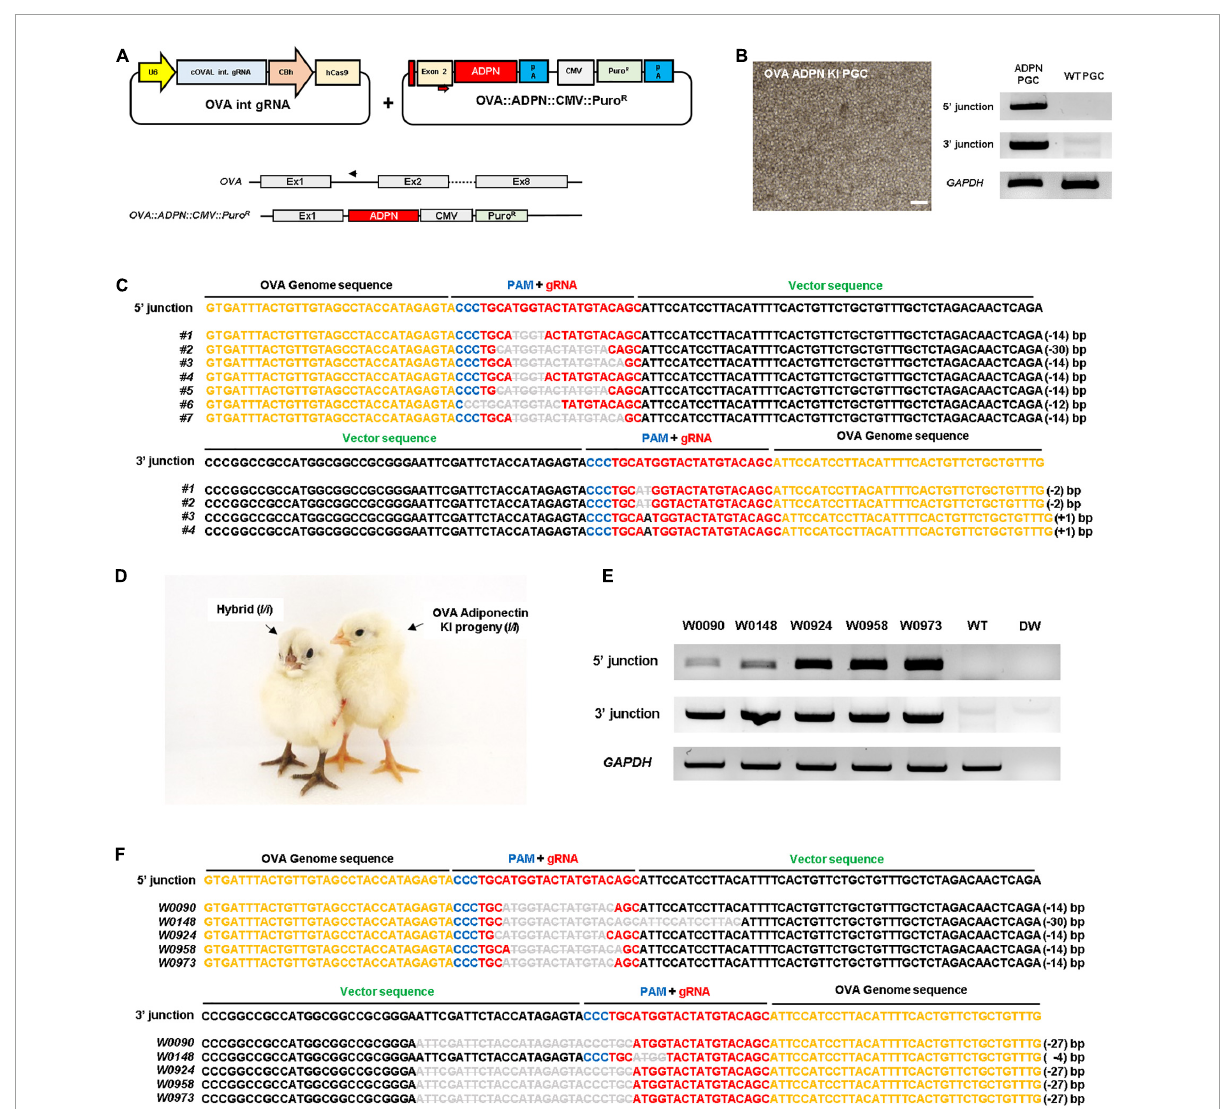
FIGURE1 Targeted gene insertion of human ADPN at Ovalbumin (OVA) gene locus of chicken PGCs and establishment of transgenic chickens. (A) A schematic illustration of the OVA targeting single guide RNA expressing vector with ADPN containing donor plasmid by using non-homologous end joining (NHEJ) repair system. The OVA targeting single gRNA expression vector targets the intron region between exon1 and exon2 of OVA gene (PAM sequence is indicated by blue bar, guide RNA recognition region is indicated by red bar). The donor plasmid contains ADPN fusion DNA including the start codon region of OVA exon2 and contains CMV Puro R (puromycin resistant gene) cassette. (B) OVA ADPN KI PGCs and the genomic DNA PCR for ADPN gene integration. The modified gene includes the synthesized exon2 partial region, ADPN gene, and CMV Puro R , and verified the inserted DNA is 5 (cid:48) junction with OV seq F and ADPN 5 (cid:48) R, and 3 (cid:48) junction with ADPN 3 (cid:48) F and OV int seq R primers. Scale bar = 200 µ m. (C) Sequencing analysis of genomic DNA PCR of donor cassette gene insertion in chicken PGCs using 5 (cid:48) junction and 3 (cid:48) junction sequence-specific PCR primers. (D) Images of donor PGC-derived OVA ADPN KI transgenic chicks ( I/I ) and hybrid individuals ( I/i ). (E) Genomic DNA PCR of OVA ADPN KI chickens using 5 (cid:48) junction and 3 (cid:48) junction sequence-specific PCR primers, and (F) sequencing analysis of OVA ADPN KI chickens. (C,F) The black text is the OVA genome sequence, the gRNA sequence is red text, the PAM sequence is blue text, and the donor vector sequence is green text. The deleted nucleotide sequence is expressed as a bar in gray uppercase text, substituted nucleotide sequence as gray uppercase text without bar, and inserted nucleotide as gray